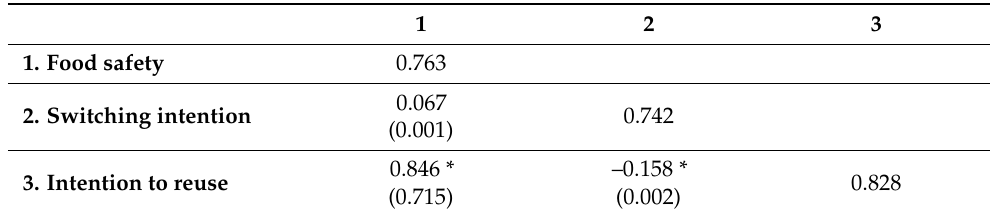
Table 4. Correlation